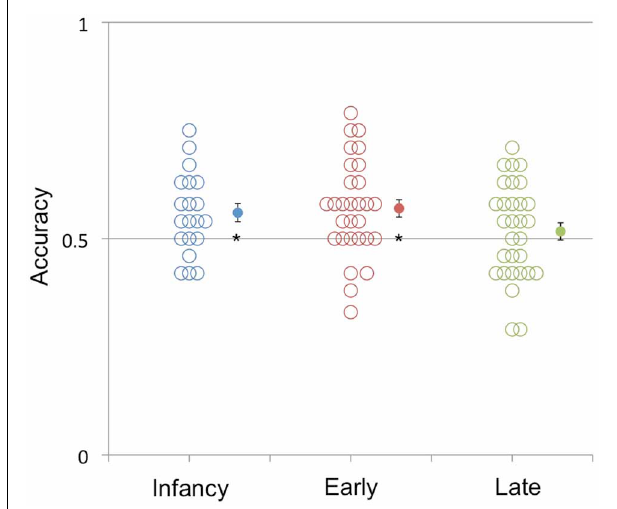
FIGURE 2 | Accuracy in identifying whether silent video clips were from the same or different languages of multilingual adults who had learned English: simultaneously with another language before age 2 (Infancy), between age 2 and 6 (Early), and after the age of 6 (Late). The y -axis represents mean accuracy and the x -axis represents the age at which English was learned. Filled-in symbols represent the group means. Error bars represent the standard error of the mean. ∗ p < 0 .